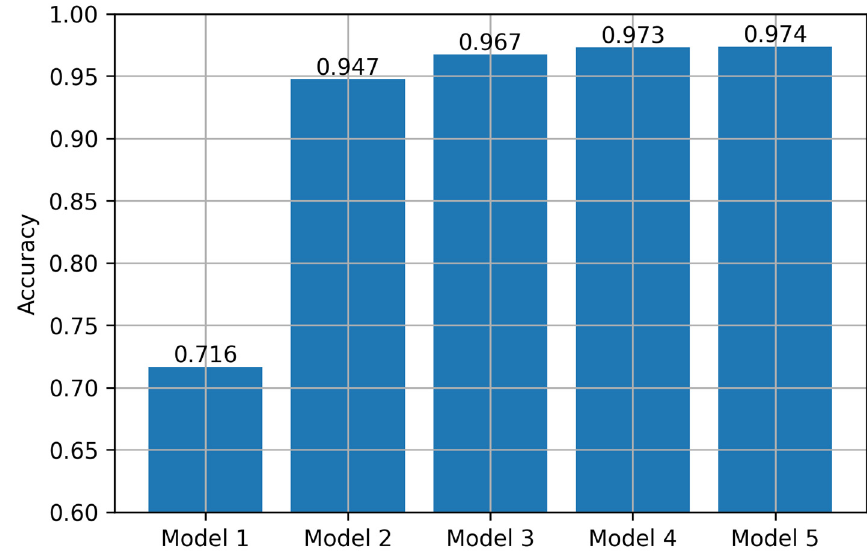
Figure 17. Accuracy of ResNet50 models with data augmentation.